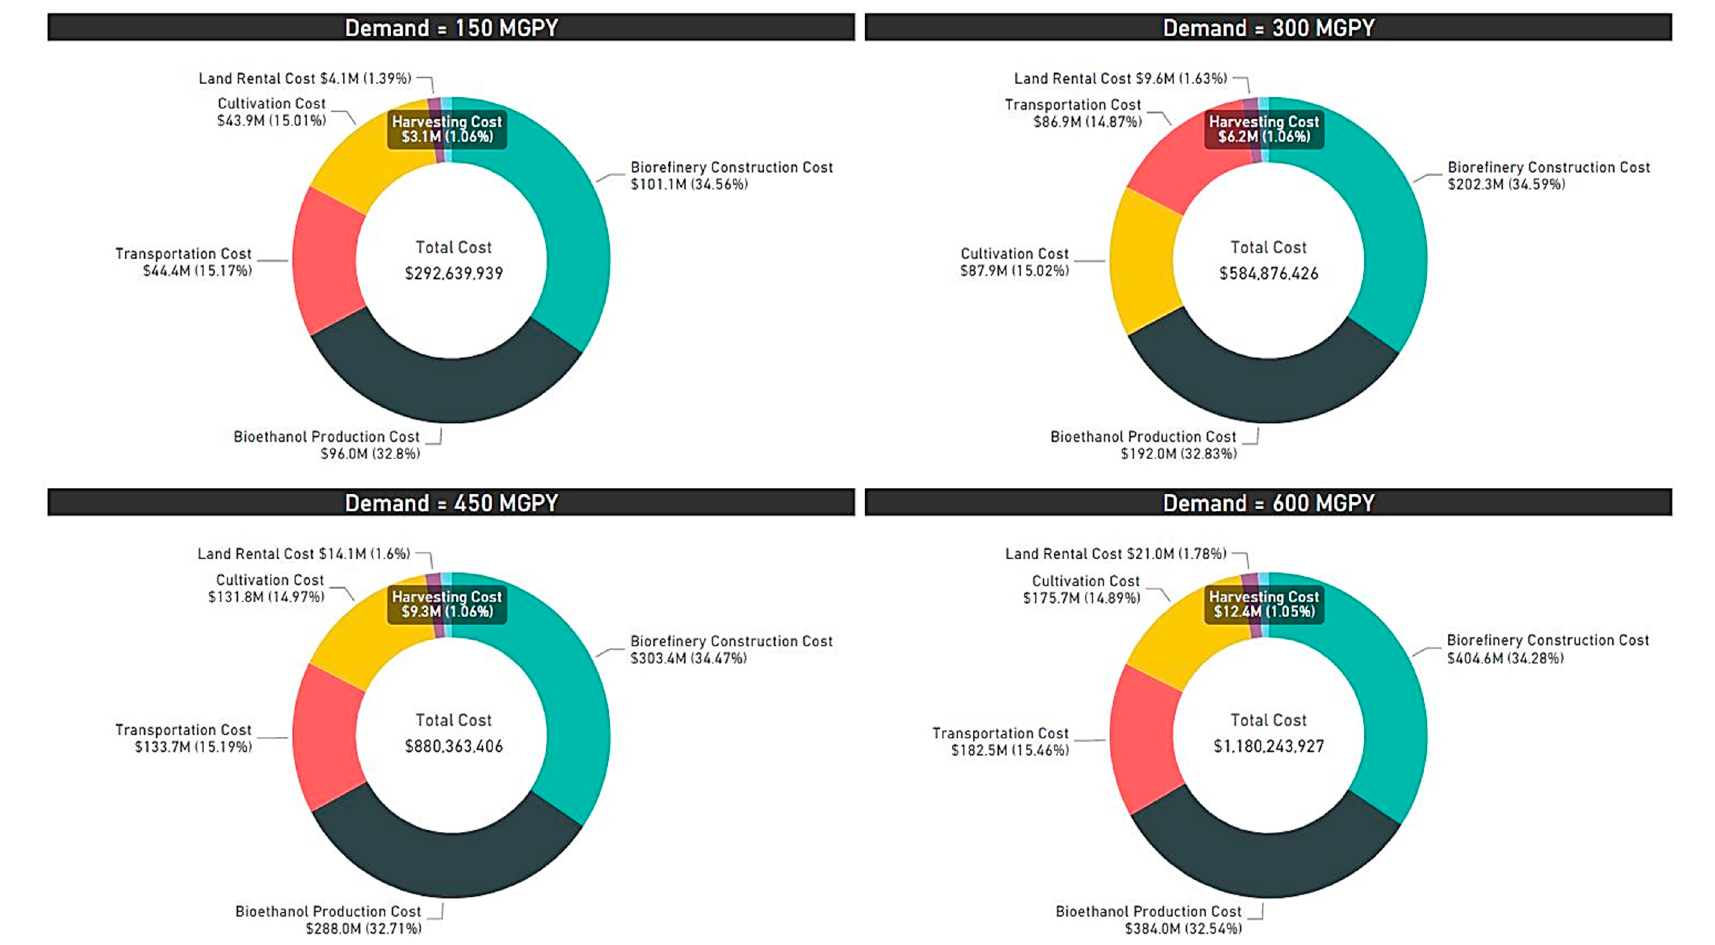
Figure 5. Cost breakdown of SBSC with different demand levels disregarding emissions and energy consumption penalties.